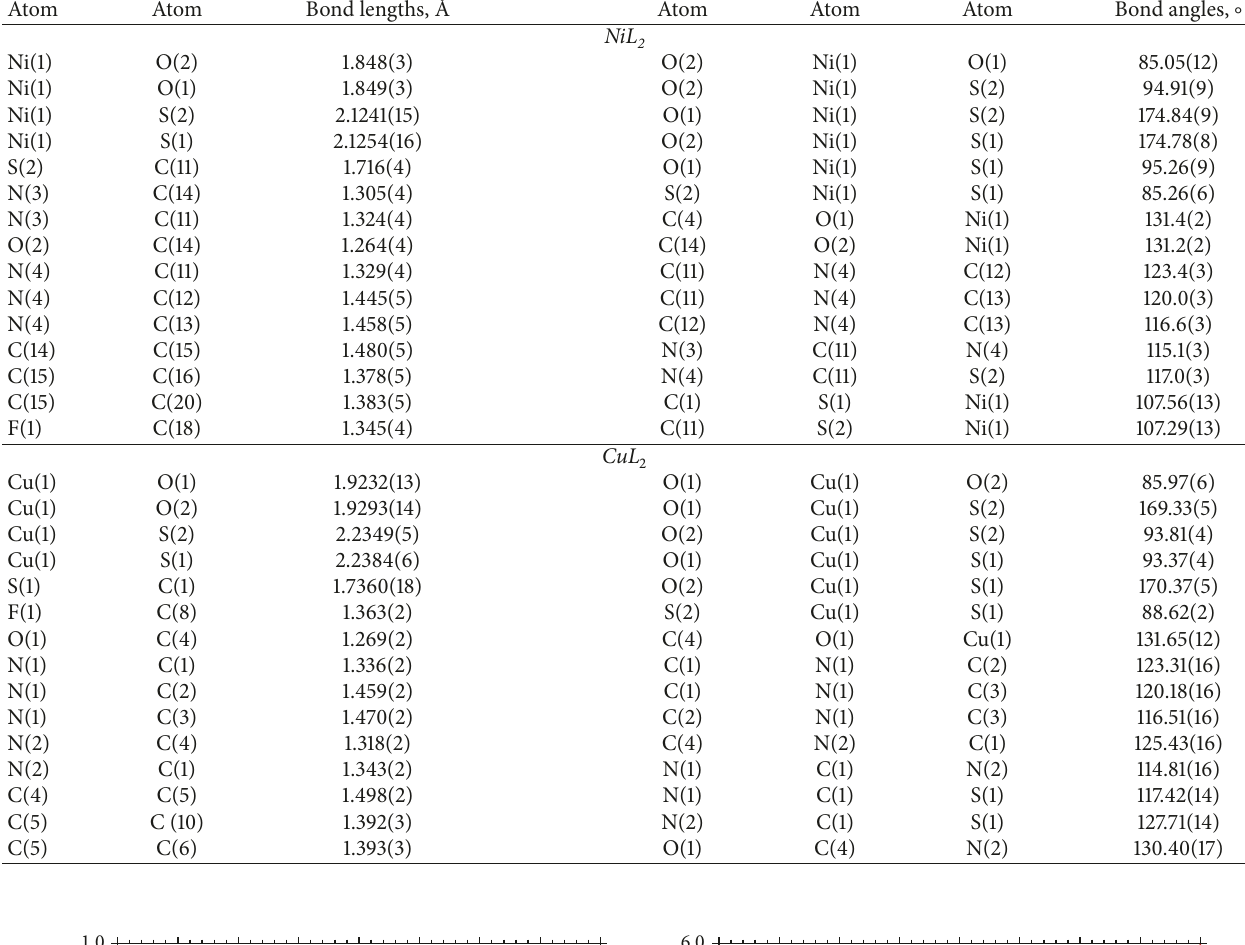
Table 2: Bond lengths and angles for NiL 2 and CuL 2 complexes.